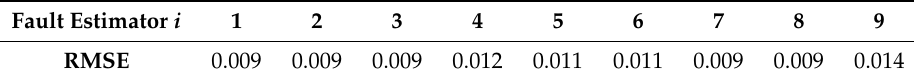
Table 7. NN performance in terms of RMSE.